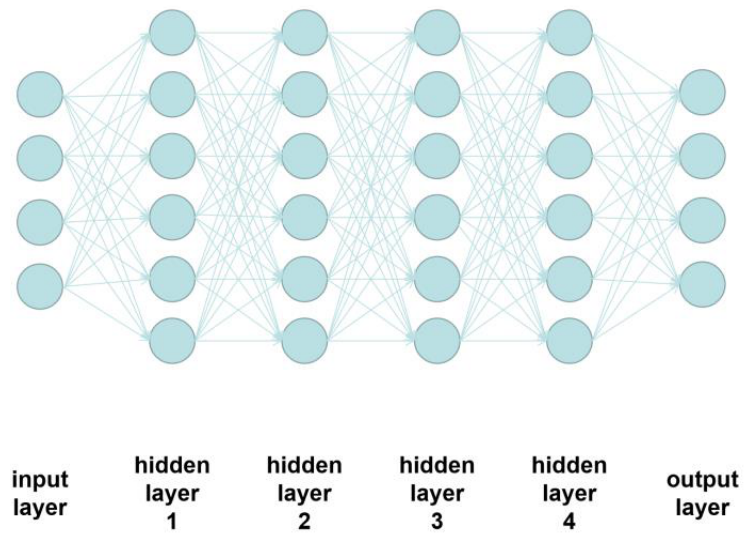
Figure 7. Schematic of the NN [5].